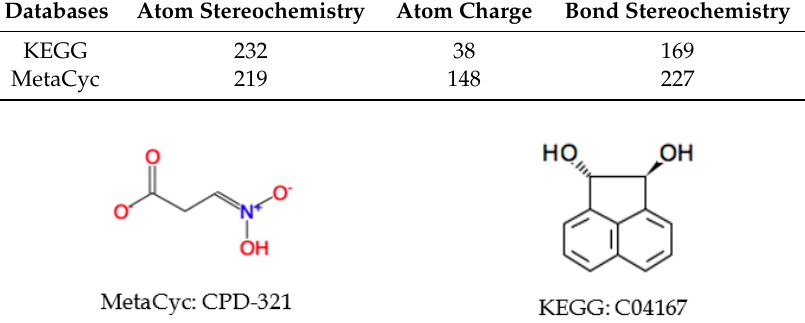
Figure 8. Examples of compounds gaining asymmetry after the addition of tight atom coloring information. For CPD-321, the two oxygens bound to the nitrogen are asymmetric with tight atom coloring and symmetric with loose atom